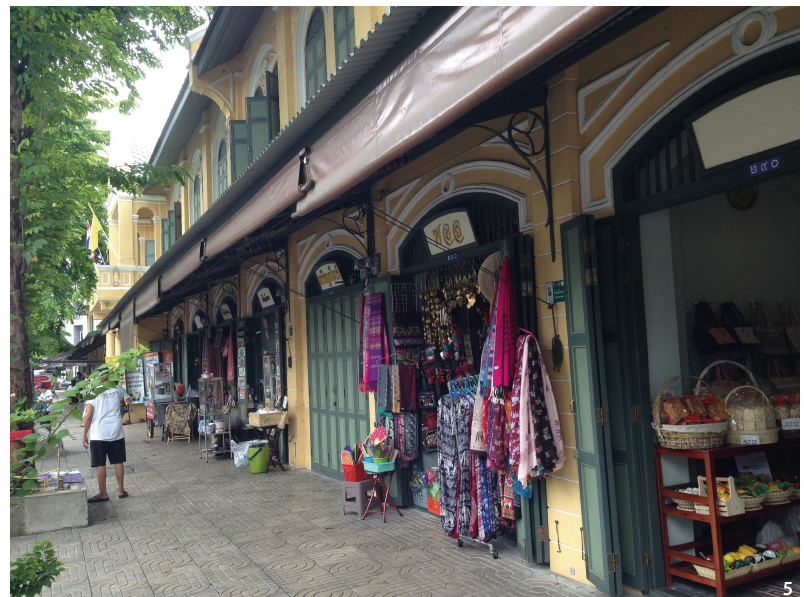
Figure 5 Tha Tien after restoration (Source: the